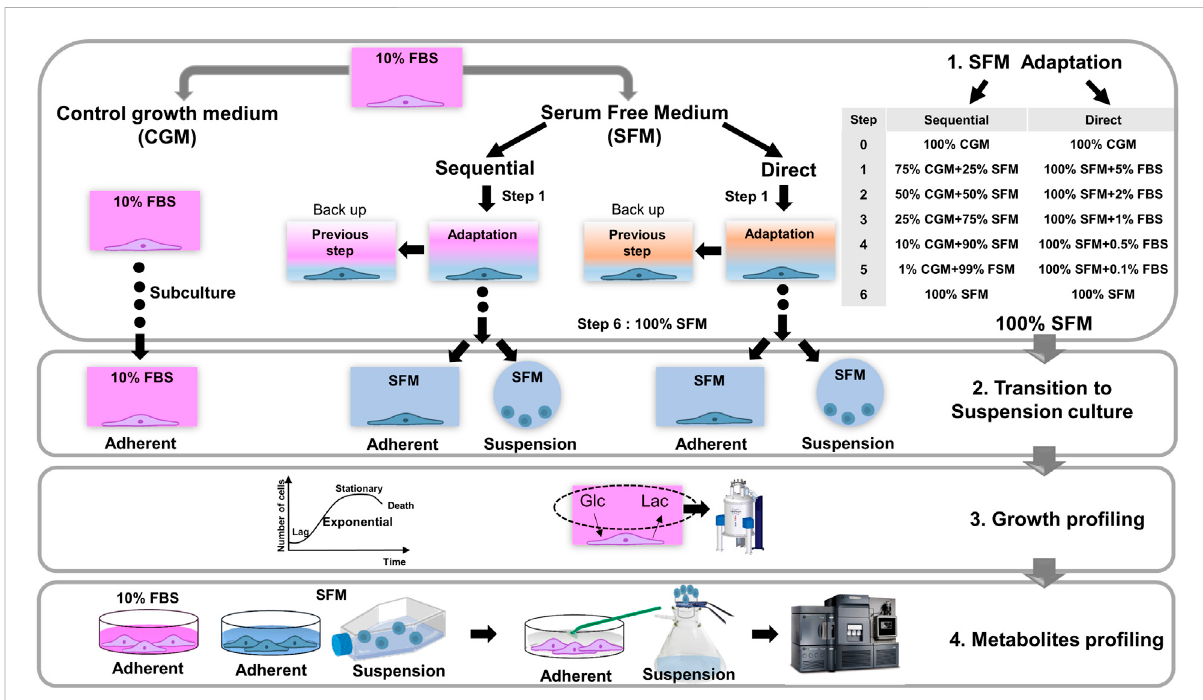
FIGURE 1 ASchematicwork fl owofthecurrentstudy.1)Strategiesfortheadaptationproceduresofserum-freeculturesofHEK293cellsbysequentialand direct adaptations in Freestyle293 medium. The portion of serum is gradually reduced according to each step, described in Supplementary Table S1. Untilreaching the100%serum-freemedium,cells weregrown inadherent culturemode.During theproceeding ofadaptation,backup cell samples were prepared in parallel under the same conditions as in previous step. 2) Establishment of fi nal serum-free cultures for both adherent and suspensionmodes.Thetransitionofadherenttosuspensionculturewasperformedatthisstage.Intotal,5differentculturesystemswereestablished (CGM; control growth medium culture , SFM Seq Ad; Serum-free medium sequential adapted adherent culture, SFM Dir Ad: Serum-free medium direct adapted adherent culture, SFM Seq Sus; Serum-free medium sequential adapted suspension culture, SFM Dir Sus; Serum-free medium